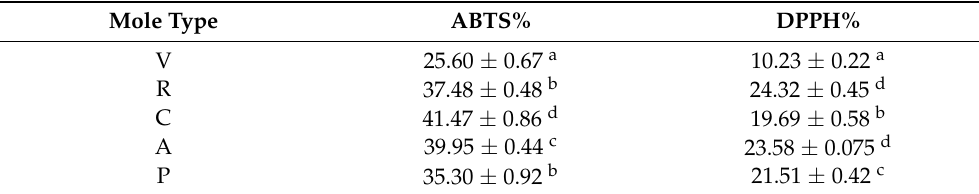
Table 7. Percentages of inhibition of five varieties of moles of the State of Hidalgo by the method of ABTS and